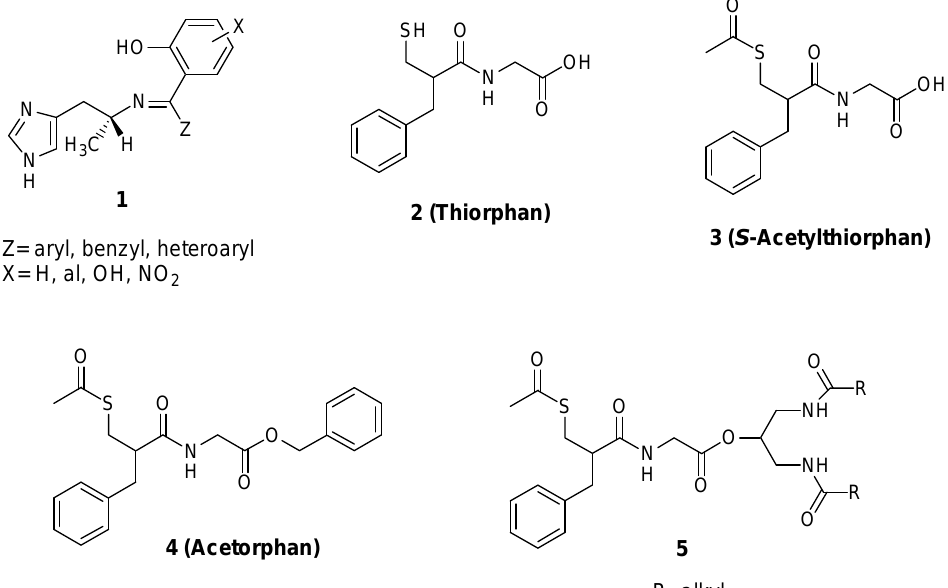
Figure 2. Chemical structures of azomethine prodrugs of ( R )- α -methylhistamine, thiorphan and prodrugs of